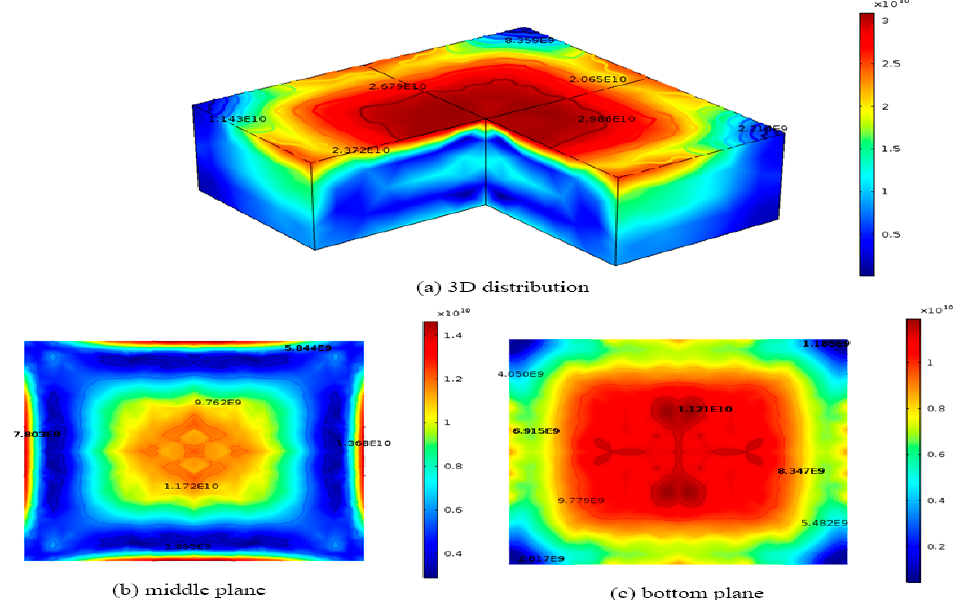
Figure 5. Dislocation density distributions of 0.84 m × 0.84 m × 0.3 m ingot at the end of the cooling process obtained from the critical resolved shear stress model (CRSS) model with the original cooling process ( a ) 3D distribution; ( b ) middle plane; ( c ) bottom